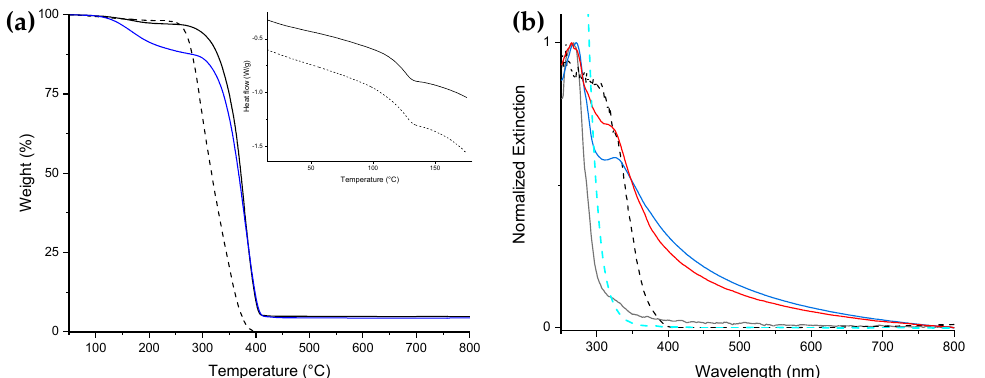
Figure 1. ( a ) TGA traces (air atmosphere) of PMMA (black dashed line), NC1 (black line), and BL (blue line). Inset: DSC traces of NC1 (black line) and PMMA (black dashed line). ( b ) UV–Vis normalized spectra of PMMA (black line), BL (blue line), and NC1 thin films (red line), TiO 2 powder (black dashed line), and glass (cyan dashed line).